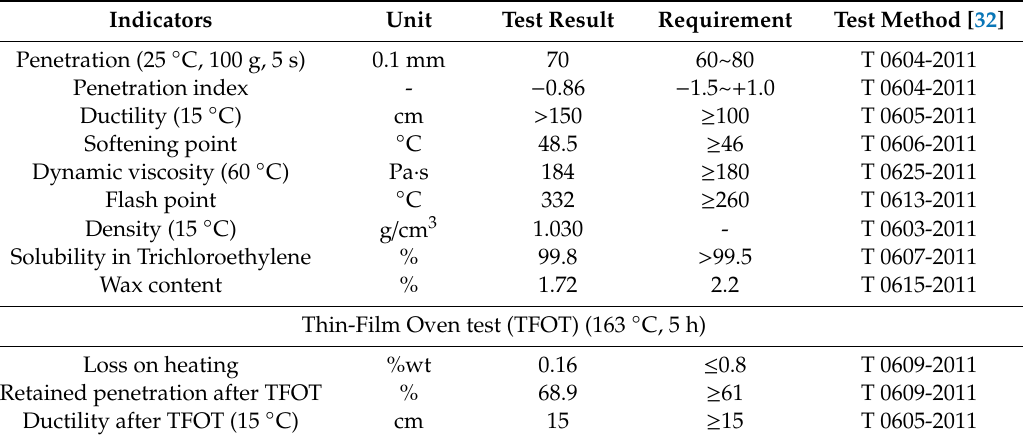
Table 1. Technical indicators of matrix asphalt binder.